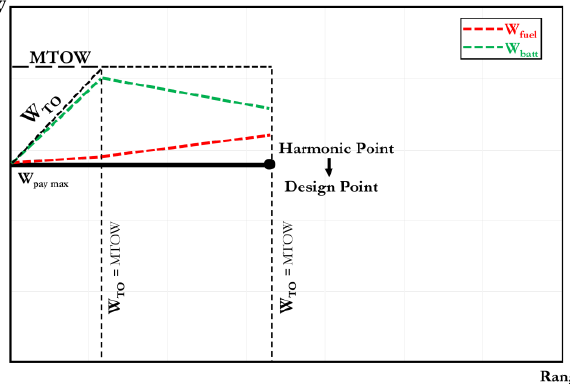
Figure 17. Payload – range diagram for hybrid-electric aircraft — Part 1. Figure 17. Payload–range diagram for hybrid-electric aircraft—Part